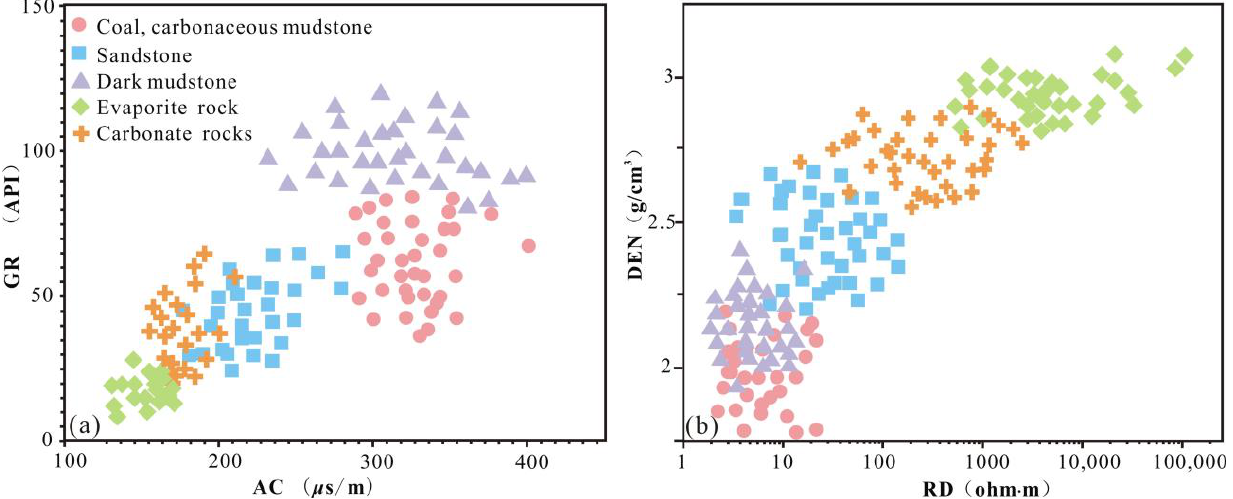
Figure 3. Log cross plots of different lithologies of the Karashayi Formation in the Bamai area. ( a ) AC-GR cross plot. ( b ) DEN-RD cross plot.